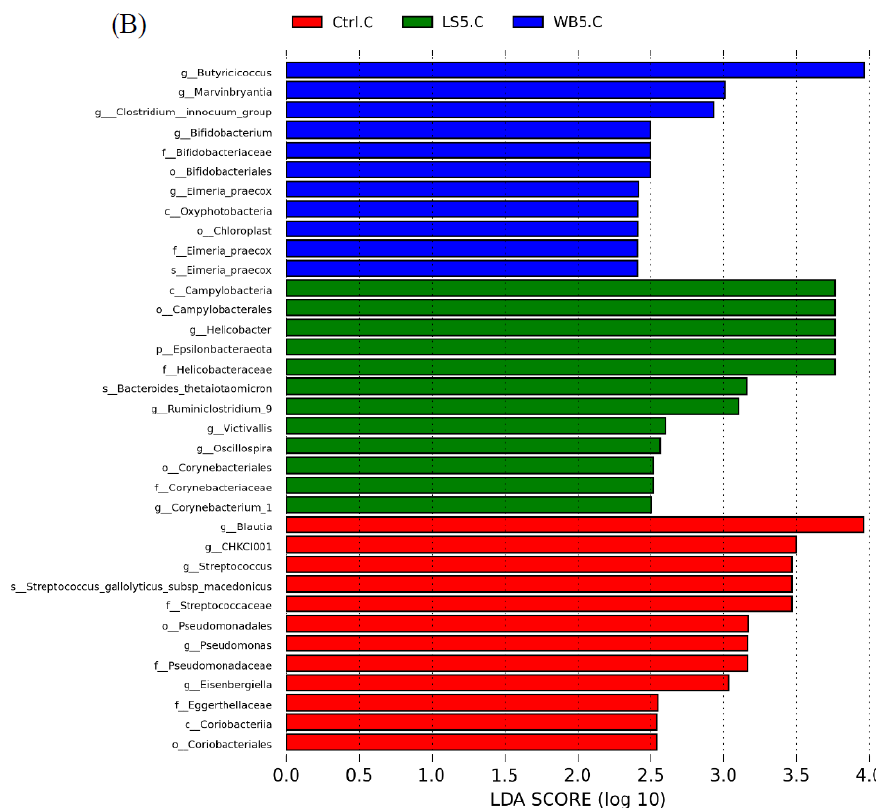
Figure 5. LefSE showing the microbiota composition in the ileum ( A ) and cecum ( B ) of 35-day-old broilers. Ctrl: control group; WB5: broilers supplemented with 5% wheat bran; LS5: broilers supplemented with 5% Laetiporus sulphureus wheat bran. Results are means of six samples obtained from the individual birds of each of the control and experimental